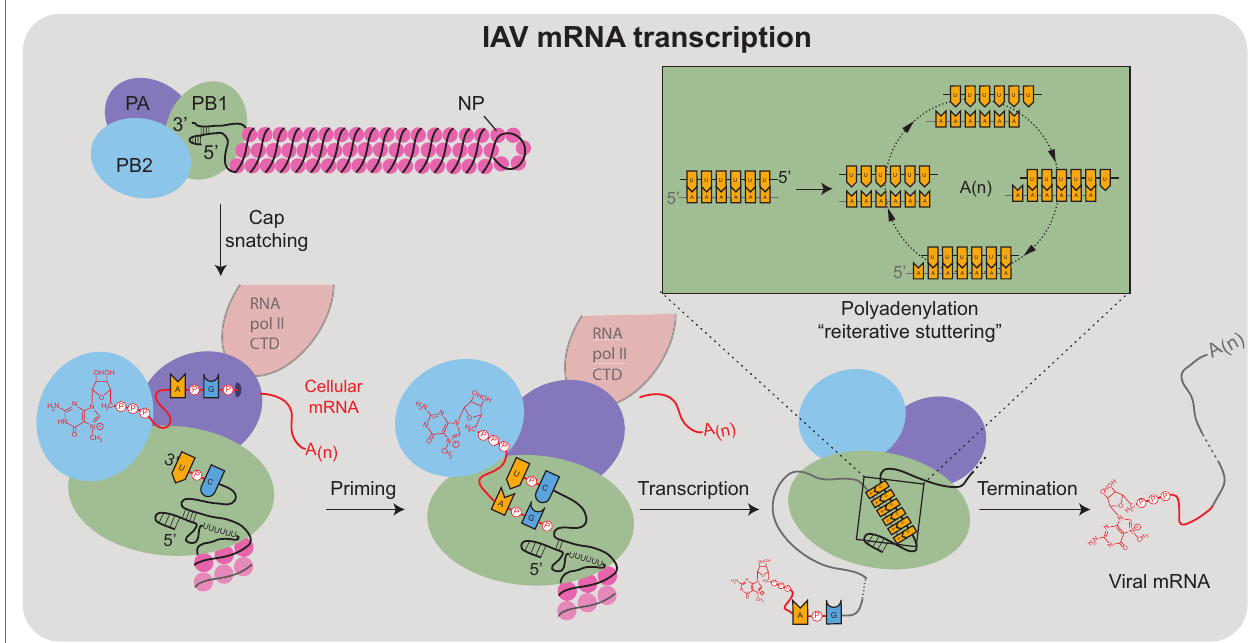
FigURe 4 | Transcription of IAV mRNAs by the viral polymerase. Viral mRNA transcription occurs when the viral ribonucleoproteins reach the host cell nucleus and is assisted by the association of the viral polymerase (PA subunit) with the cellular RNA polymerase II C-terminal domain (RNA pol II CTD). Transcription initiates by a “cap-snatching” mechanism where the PB2 subunit binds to the 5 ′ cap of a host mRNA (red). Cap binding positions the region of the mRNA 10–13 nucleotides downstream for cleavage by the endonuclease domain in the PA subunit. Following cleavage, a conformational shift repositions the acquired mRNA capped primer to the PB1 subunit where the 3 ′ end base-pairs with a complimentary sequence at the vRNA 3 ′ end. Following the priming event, the viral polymerase extends the mRNA transcript. The transcription is terminated by a “reiterative stuttering” process (depicted in the box), which occurs when the polymerase encounters the 5–7 consecutive uracil bases at the vRNA 5 ′ end. The “reiterative stuttering” function likely involves multiple cycles of dissociation and reannealing, and effectively polyadenylates [A(n)] the viral mRNA by continuously repositioning the elongating 3 ′ end on the uracil-rich region of the vRNA